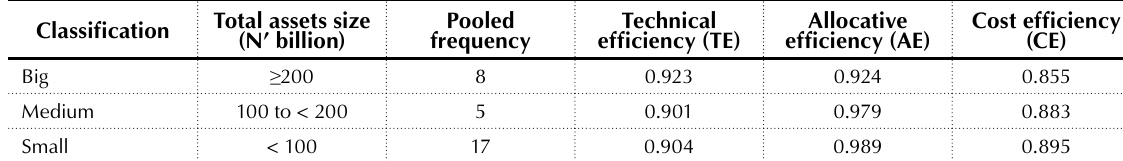
Table 6. Measured mean efficiency of the deposit money banks in 2005